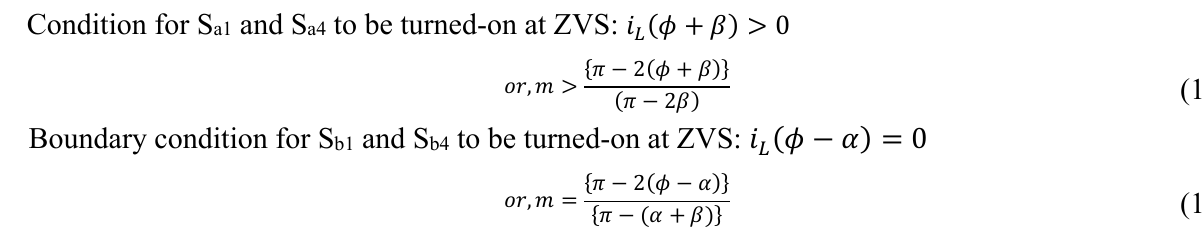
, inductor current (cid:1861) and (cid:1874) (cid:3002)(cid:3003) (cid:3028)(cid:3029)